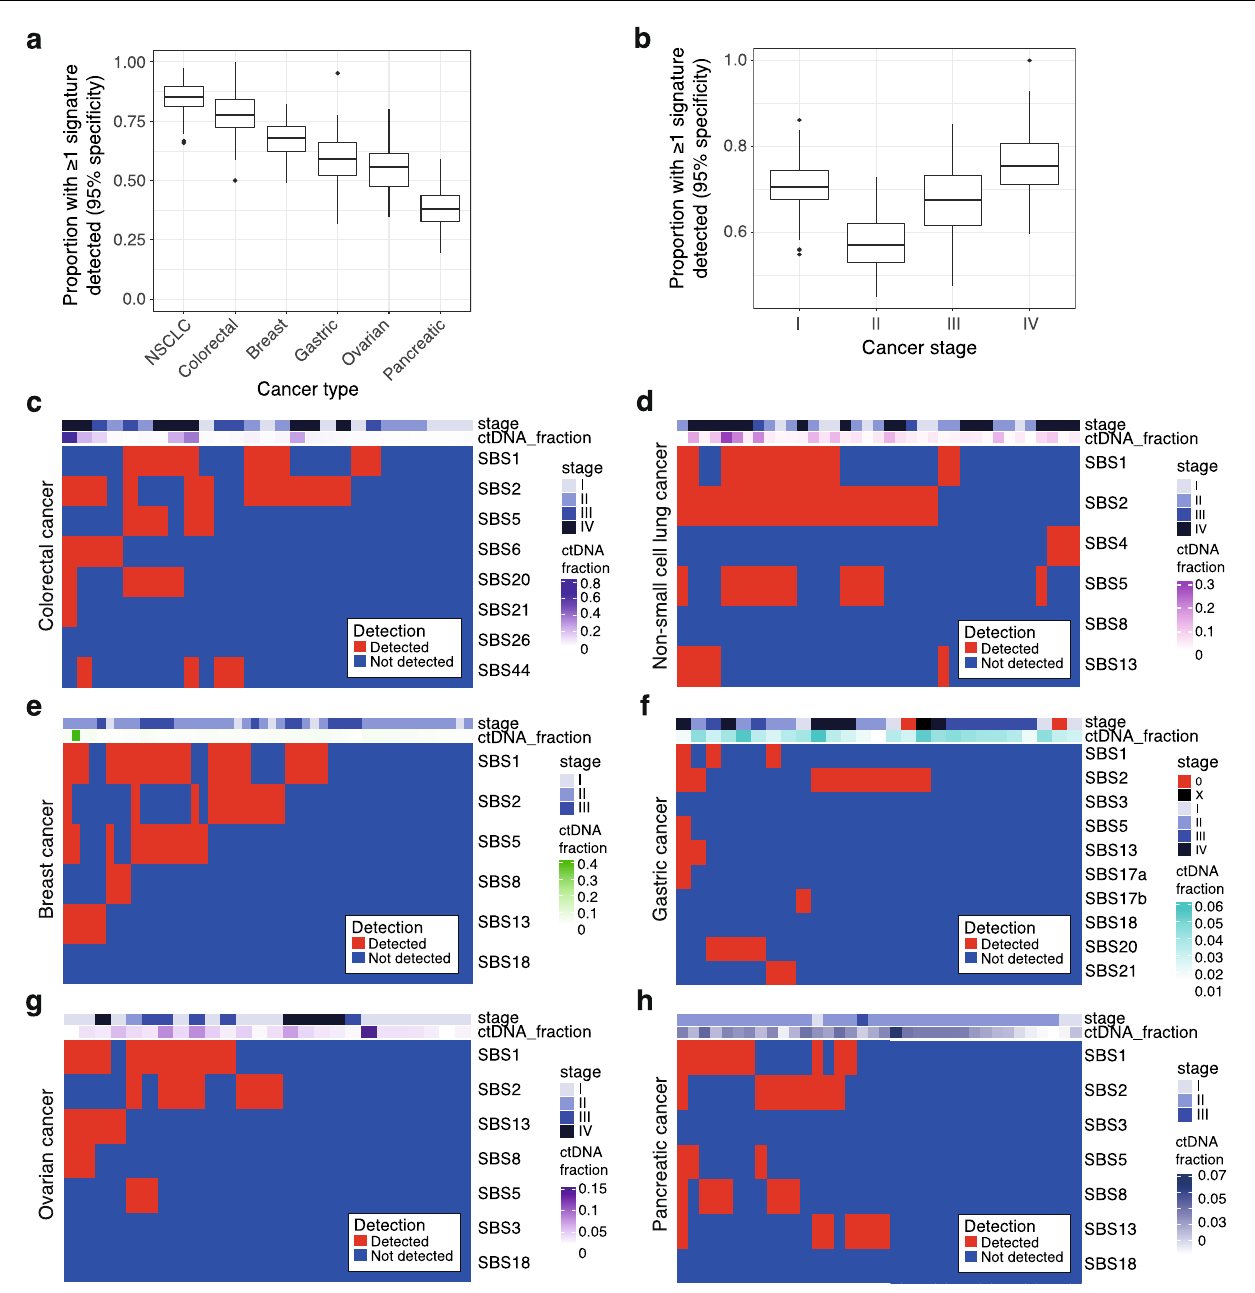
Boxplots show the bootstrapped median, upper and lower quartiles, and whiskers indicate1.5×IQR.Outliersareshownaspoints. c – h